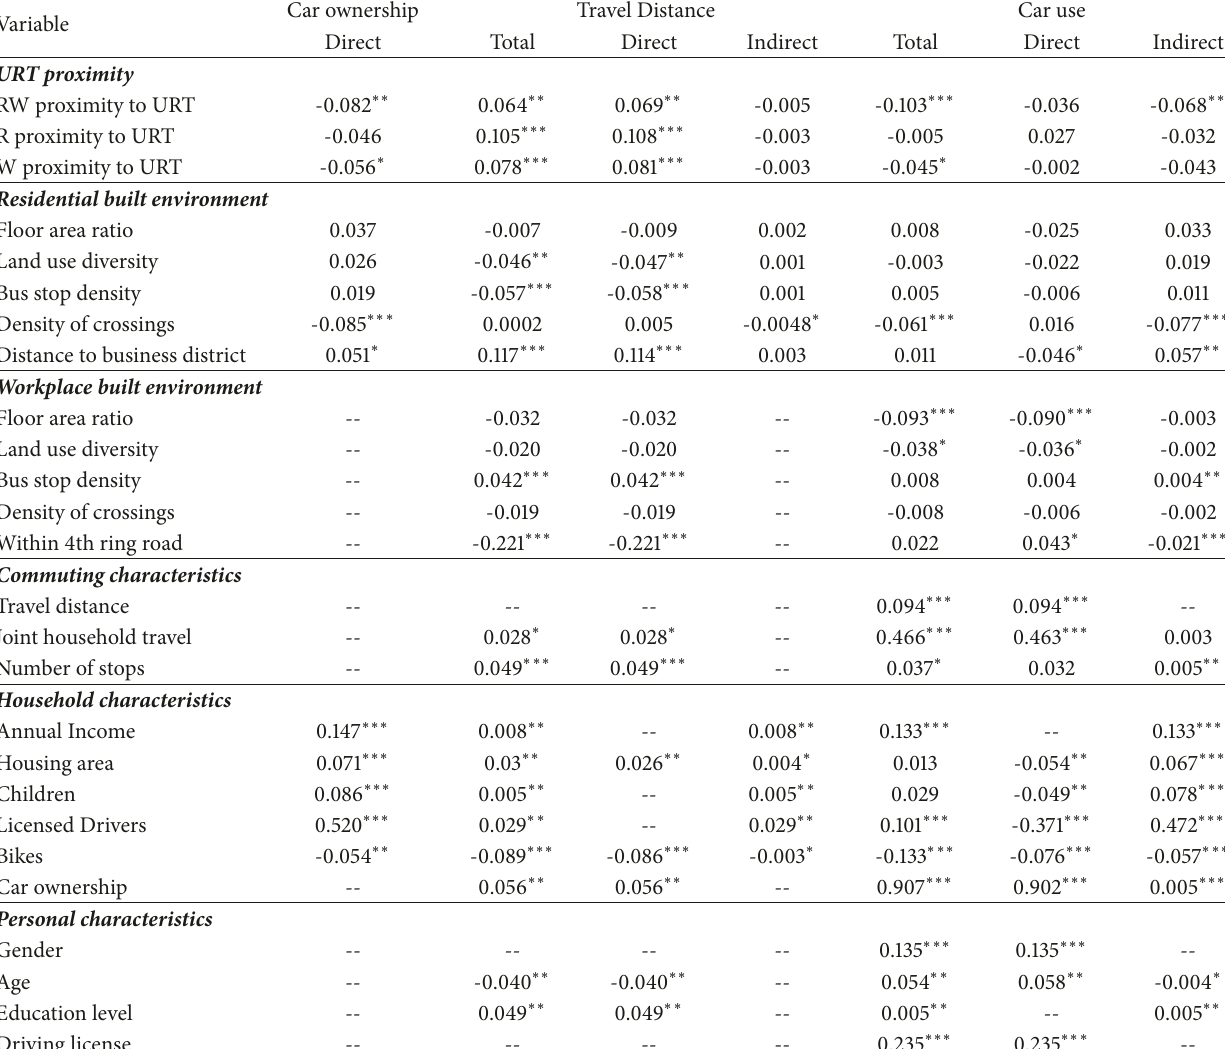
Table 3: Standardized direct, indirect, and total effects on car ownership, travel distance, and car